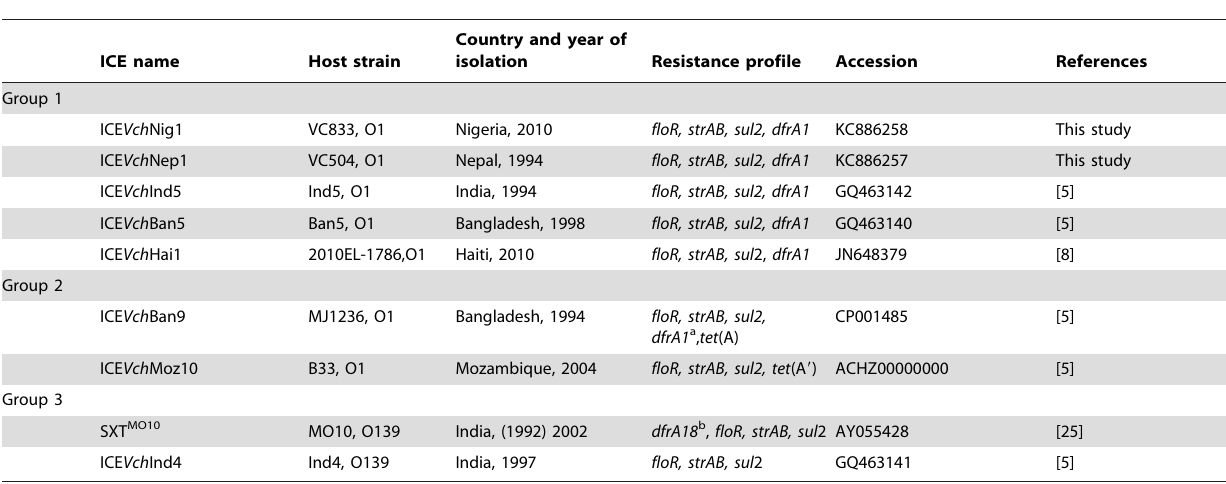
Table 1. Groups of integrative and conjugative elements with similar gene content found in epidemic V. cholerae